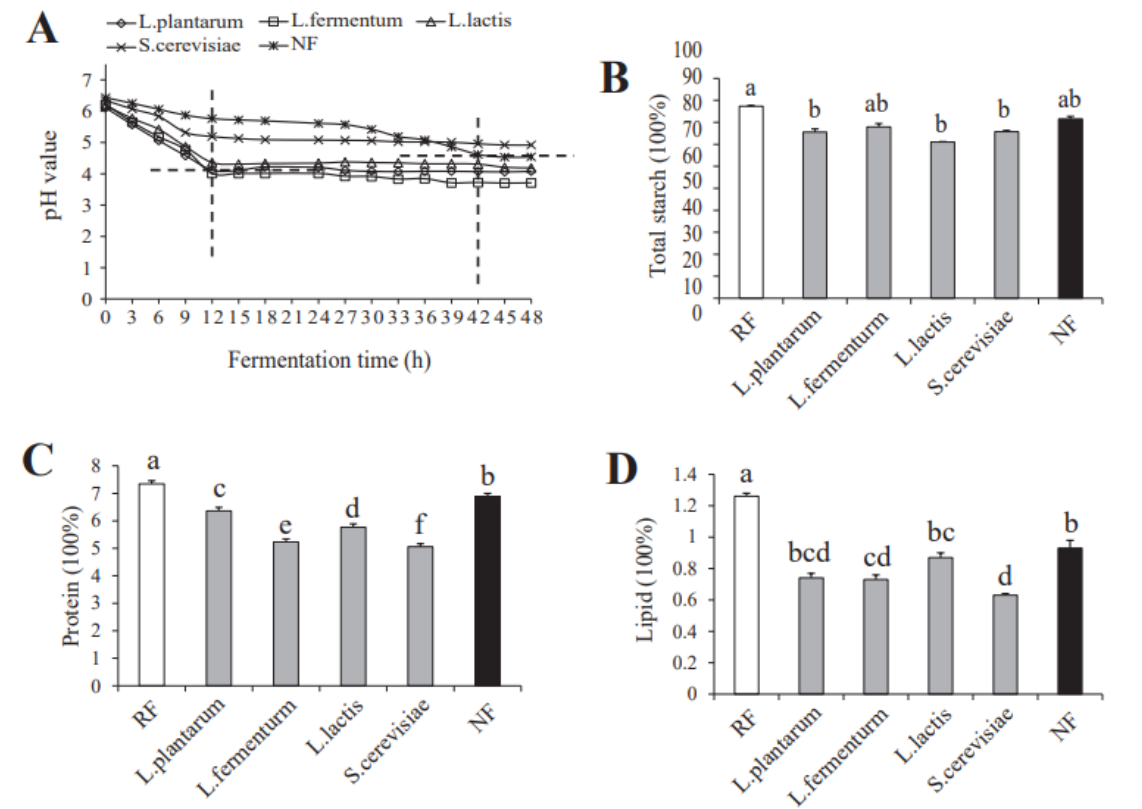
Figure 1. The pH value ( A ) of the fresh fermented rice noodles and the total starch content ( B ), protein ( C ), lipid ( D ) of the RF, L. plantarum , L. fermentum , L. lactis , S. cerevisiae and NF rice noodles. Mean values ± standard deviation, n = 3. Different superscript letters indicate significant differences at p < 0.05 (Tukey Kramer’s multiple comparison post hoc tests). RF means rice flour; L. plantarum represents adding Lactobacillus plantarum ; L. fermentum represents adding Lactobacillus fermentum ; L. lactis represents adding Lactococcus lactis ; S. cerevisiae represents adding Saccharomyces cerevisiae and NF represents fermented naturally .